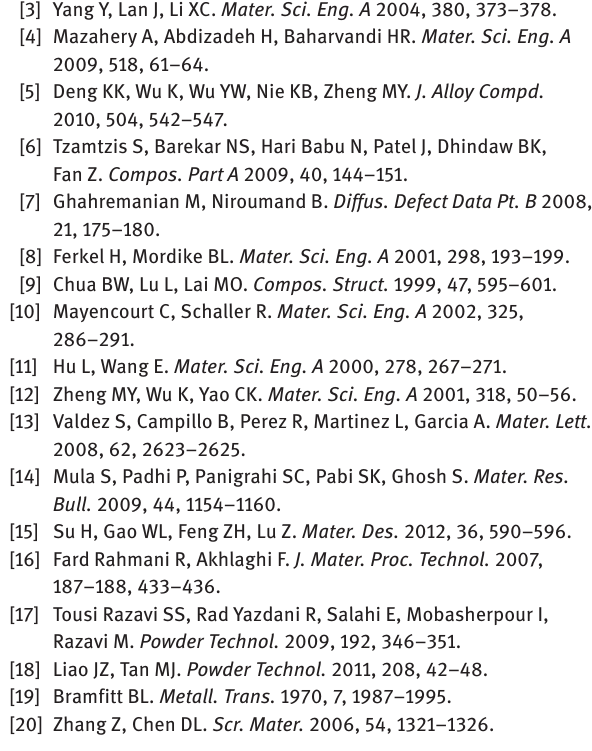
Figure 8: (A) The HRTEM image of the interface between the nano-SiC particle and the matrix in the 0.5 vol.% nano-SiC (B) the selected area electron diffraction pattern at the area B, (C) SAED pattern at the area C, and (D) IFFT image of the zone